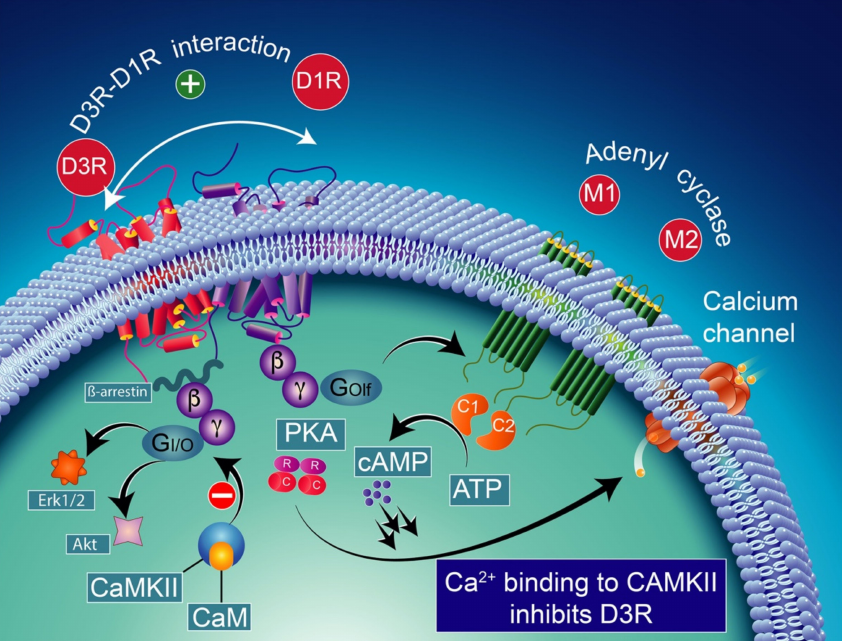
Figure 5. D1R and D3R interaction in high-level Ca 2+ conditions. Relatively low levels of CaMKII activity induced by low cytoplasmic Ca 2+ result in the full expression of D3R function through sensitization of D1Rs, which in turn can respond to lower levels of their ligand [237]. The D3R- mediated sensitization mechanism is turned off by activated CaMKII via increased intraterminal Ca 2+ . CAM-calmodulin; CaMKII-calcium/calmodulin-dependent protein kinase II; PKA-protein kinase A; Erk1/2-extracellular signal-regulated protein kinases 1 and 2; Akt-serine/threonine kinase.